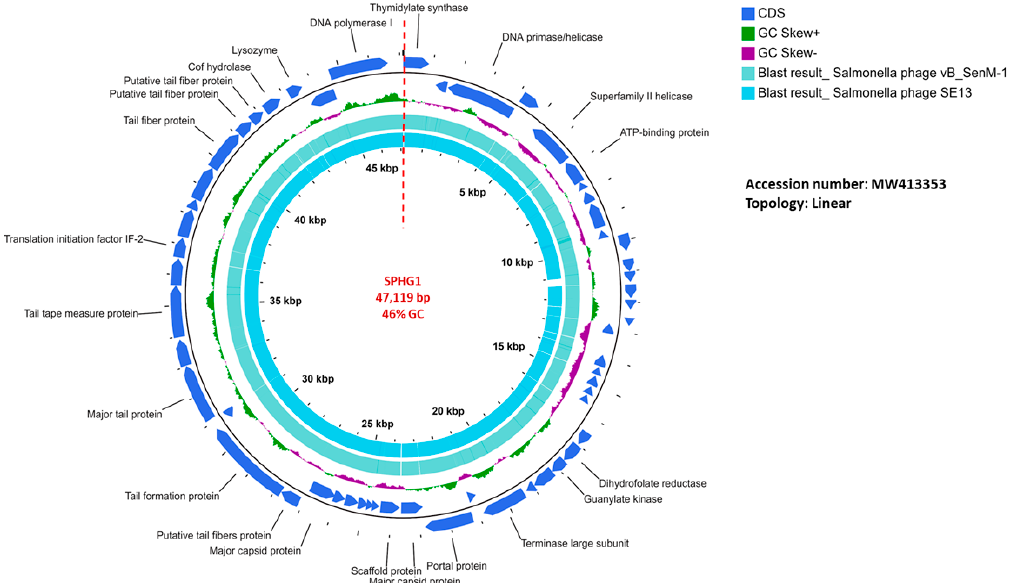
Figure 3. The SPHG1 genome organization represented as a circle. The 62 CDSs are represented as blue arrows showing the predicted genes transcribed clockwise (outer side) and counterclockwise (inner side) along the genome. The genome map is circle, but there is a break at the 12 o’clock position (at the dotted straight red line) because the phage genome is a linear molecule. CDSs with known functions are labelled along with their position; however, other non-labelled CDSs represent hypothetical proteins. The following cycle is the GC content of the genome. The inner two circles represent the BLASTn alignment of SPHG1 against Salmonella phage vB_SenM-1 and Salmonella phage SE13, respectively.